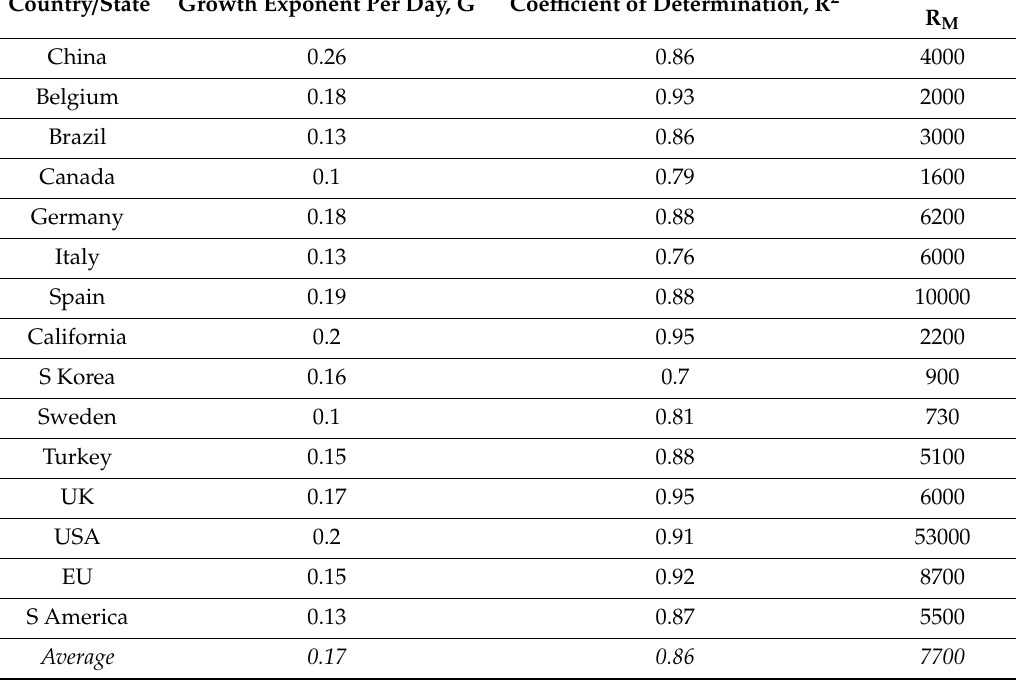
Table 1. Characteristic growth